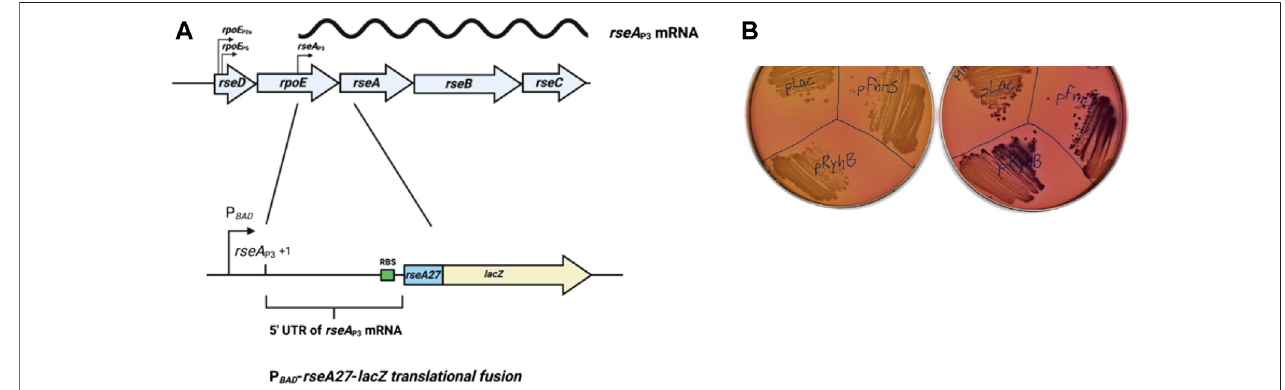
FIGURE 1 | Genetic screen for small RNA regulators (A) . Schematic of the rpoE operon with selected promoters, including the rseA P3 promoter, and the P BAD - rseA27-lacZ translational fusion utilized for the small RNA library screen. The rseA fusion consists of the rseA P3 transcript, and the fi rst nine codons of the rseA gene fused in the frame to the ninth codon of lacZ , downstream and controlled by the araBAD promoter (P BAD - rseA27 - lacZ translational fusion) (B) . P BAD - rseA27 - lacZ translational fusion strains transformed with an empty vector control (pBR-pLac), pBR- ryhB , or pBR- fnrS grown overnight at 37 ° C on MacConkey-Lactose agar plates. One plate was supplemented with 0.0002% arabinose to stimulate basal transcription of the P BAD - rseA27 - lacZ translational